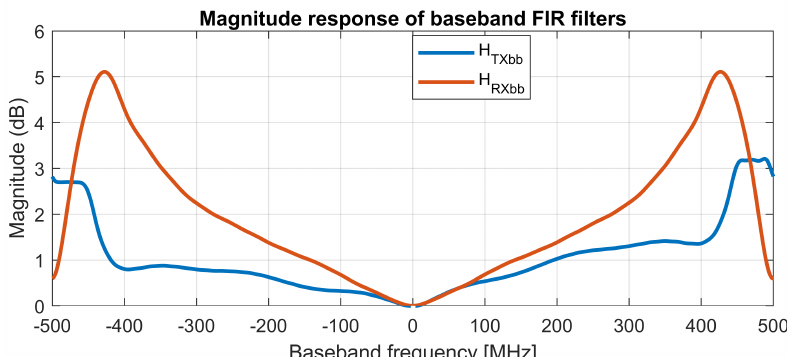
Figure 5. Frequency characteristics of baseband compensation filters H TXbb and H RXbb .